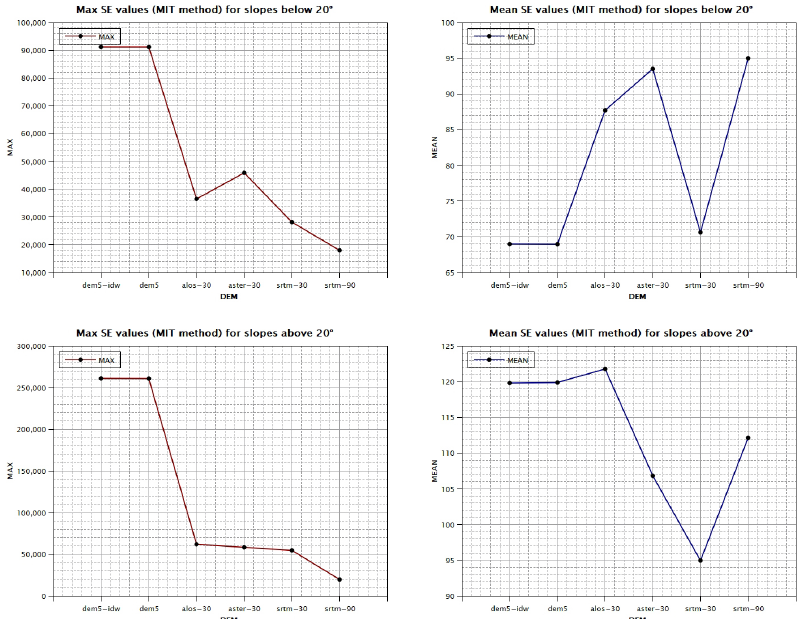
Figure 13. Maximum and mean values of SE for slopes below and above 20° (MIT method).